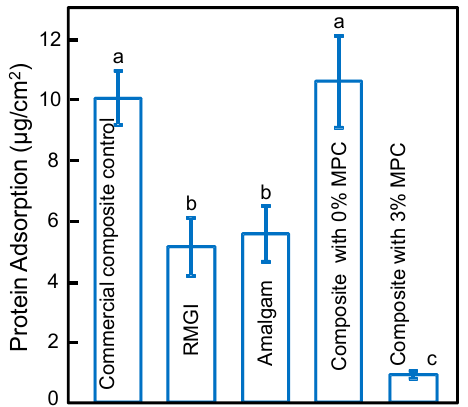
Figure 1. Protein adsorption onto disk surfaces (mean ± sd; n = 6). Incorporation of 3% MPC into the composite significantly decreased the amount of protein adsorption compared to that at 0% MPC and the commercial composite control ( p < 0.05). Dissimilar letters indicate values that are significantly different from each other ( p < 0.05).